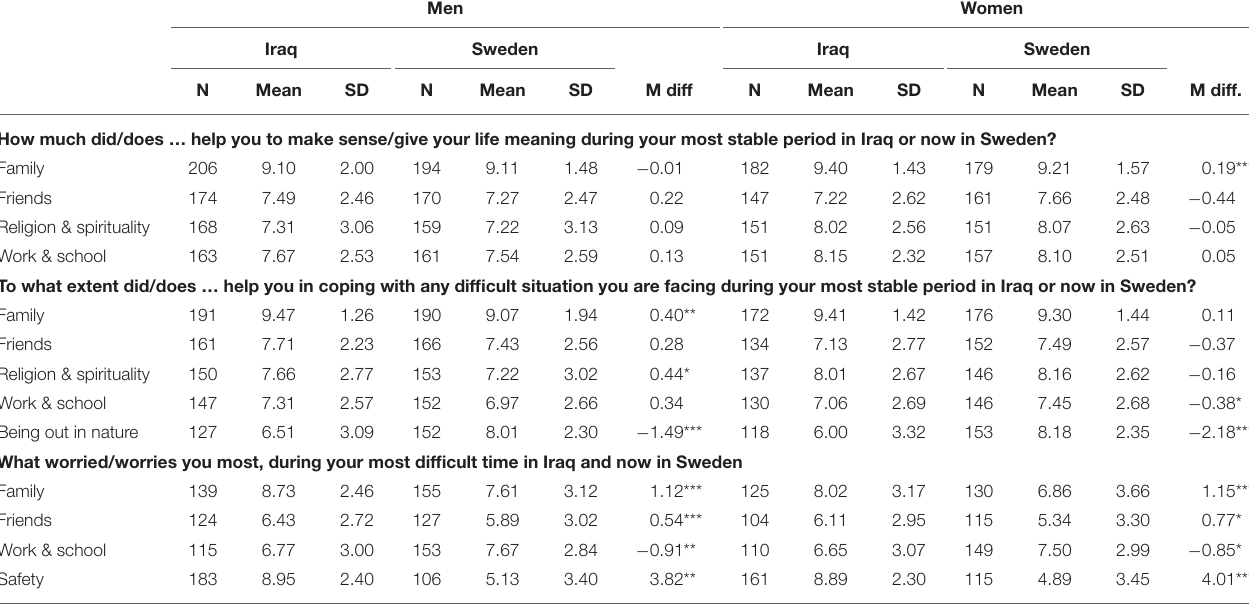
TABLE 3 | Descriptive statistics for life meaning, coping and worries, by gender and by country.